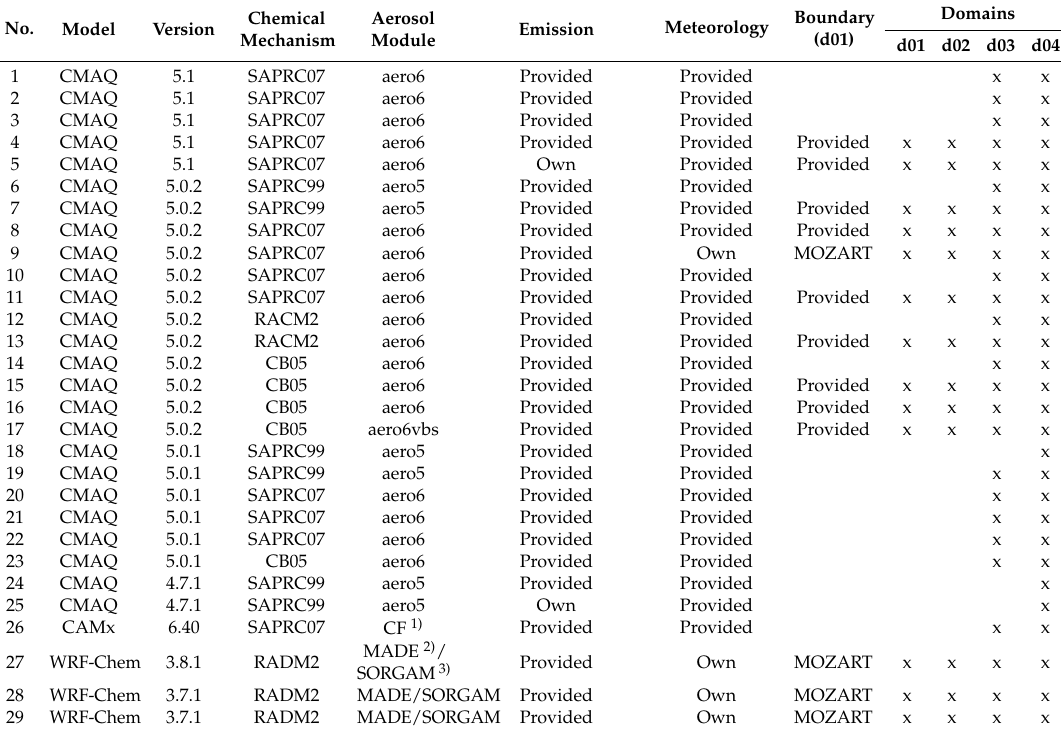
Table 4. Configurations of models participating in the first phase of